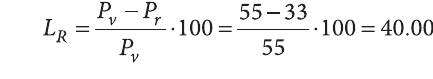
Table 10. Adjustment factors to visibility condition and to exposure of the